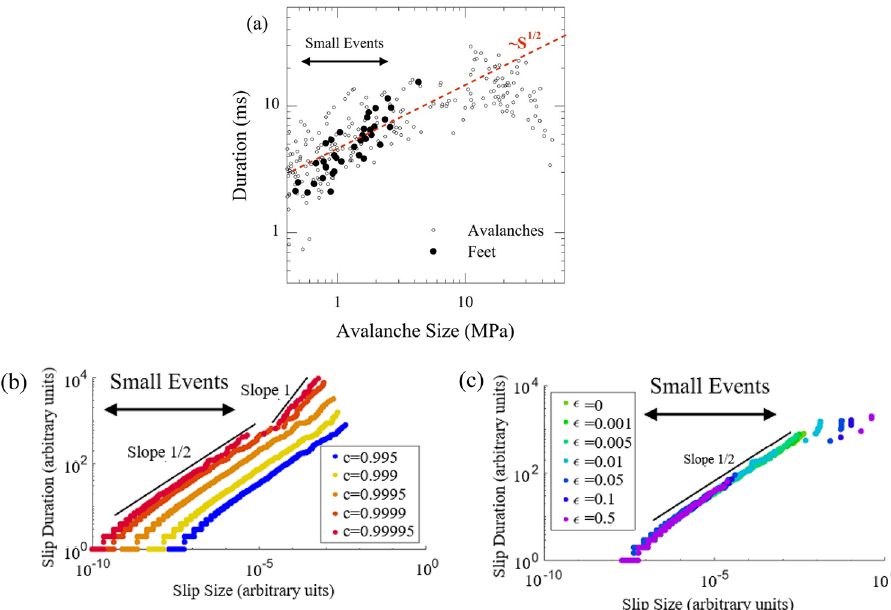
Figure 3. Experiment: ( a ) Duration as a function of size for small avalanches and for the feet of large avalanches in a Zr 45 Hf 12 Nb 5 Cu 15.4 Ni 12.6 Al 10 BMG. The statistics of the two are indistinguishable in this plot. Simulation: ( b ) Duration as a function of size for simulations of small avalanches at a range of machine stiffnesses. The durations of large avalanches scale linearly with the size of the events. This is in contrast to the observed behavior in ( a ) in which the duration of large events does not increase and may in fact decrease with size. Simulation: ( c ) Duration as a function of size for simulations of small and large avalanches for various weakenings ǫ showing behavior similar to that in ( a ). Together ( b ) and ( c ) suggest that finite stiffness of the experimental apparatus is not the cause of the behavior of the large events, but rather that weakening is. Simulations are performed adiabatically with a system size of 10 5 cells, ε = 0 and c = 0.996 except where